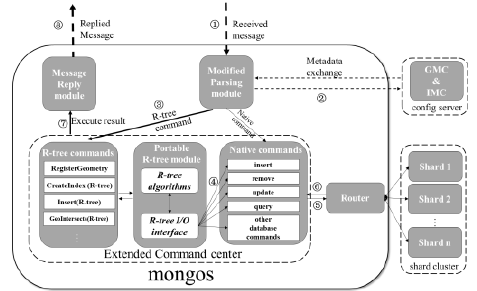
Figure 6. Integration detail of R-tree module